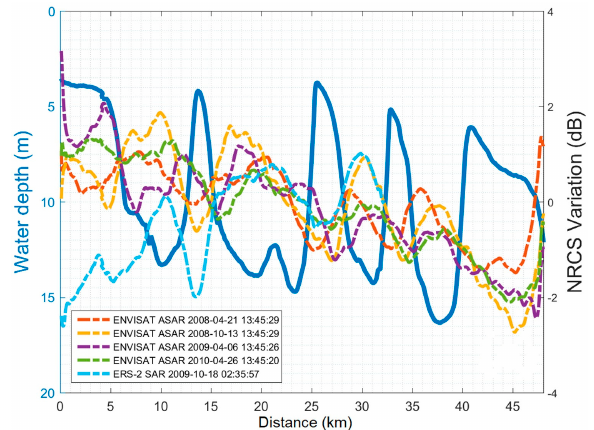
Figure 5. The water depth measured in December, 2016 (m) in blue solid line and NRCS Variation (dB) calculated from SAR data along the cross section A. The distance is measured from the left to the right for each cross section.